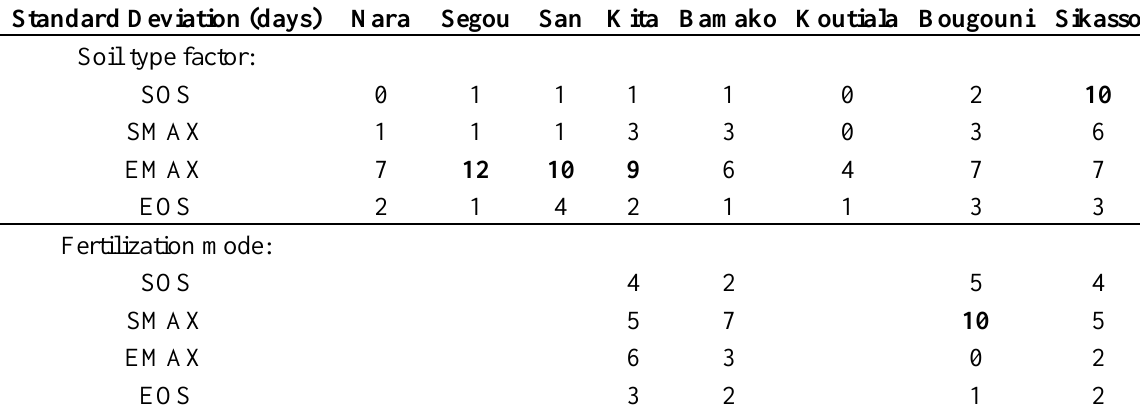
Table 4. The effect of soil type and fertilization mode on crop growth: standard deviations for the start-of-season, start-of-maximum of season, end-of-maximum of season, and end-of-season in days for each station, in 2007, with four soil types and two fertilization